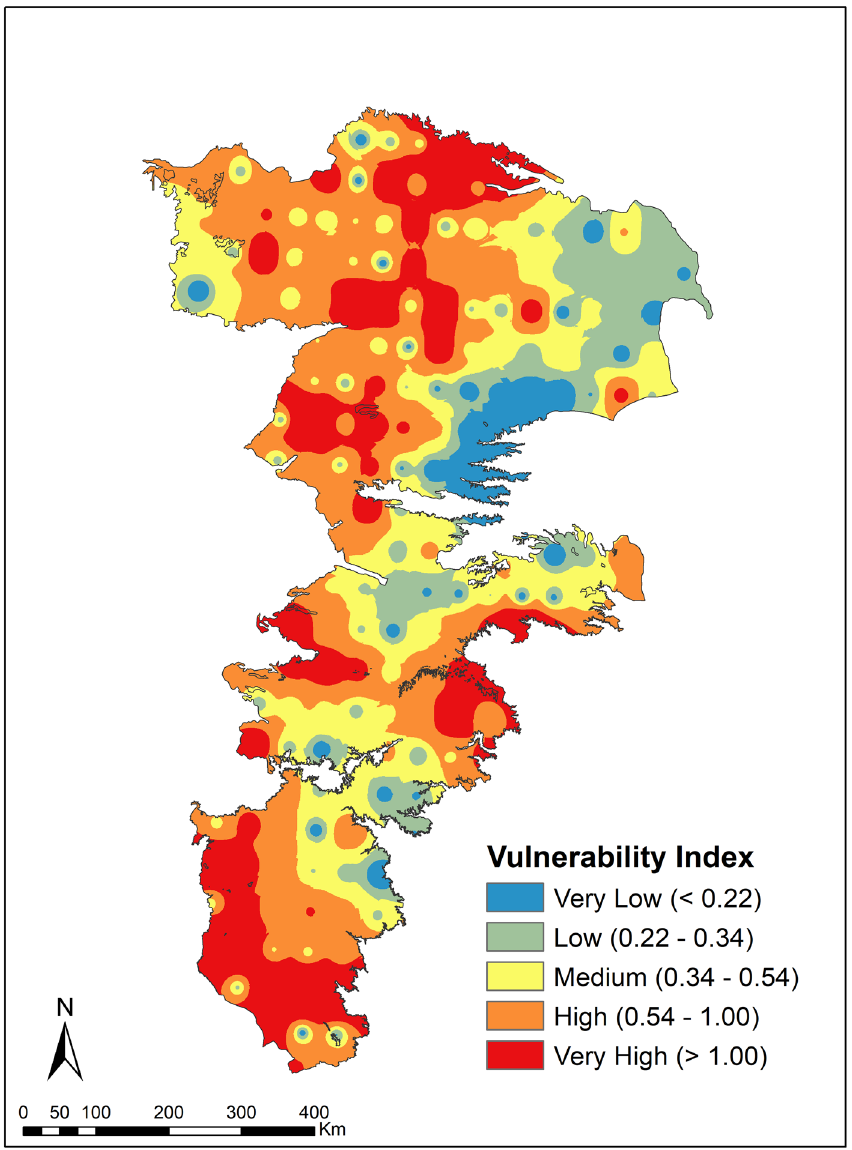
Figure 12. Overall Vulnerability Index to droughts for conditions in the year